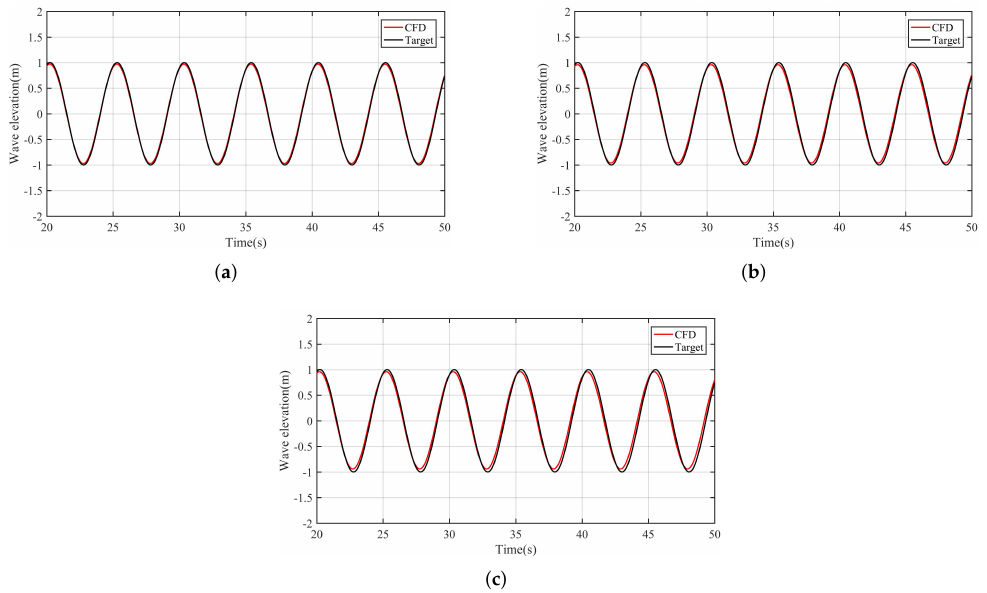
Figure 4. Comparison of 3D regular wave elevations in time: ( a ) probe P1 ( x = 0 m); ( b ) probe P2 ( x = 40 m); ( c ) probe P3 ( x = 80